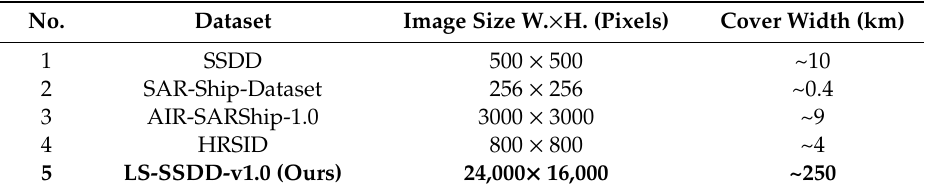
Table 3. Background